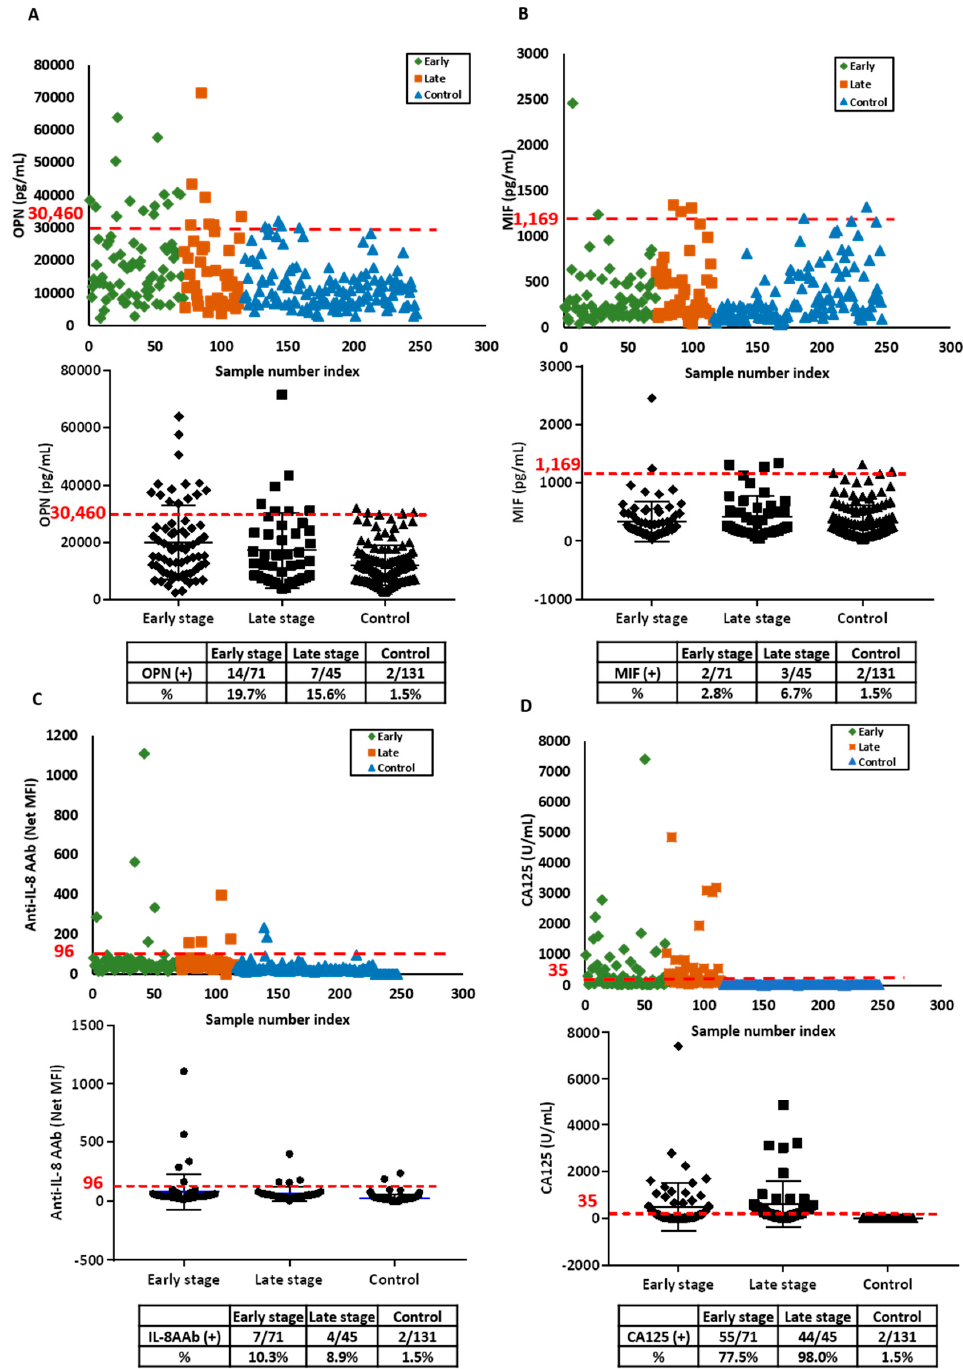
Figure 2. Serum levels of OPN, MIF anti-IL-8 autoantibody and CA125 are elevated in the validation set from ovarian cancer patients and healthy controls. ( A ) OPN antigen; ( B ) MIF antigen; ( C ) anti-IL-8 autoantibody and ( D ) CA125 antigen. In the upper panels, each symbol represents the average of duplicate serum samples from individual early stage ovarian cancer cases (green), late stage ovarian cancer cases (red) or controls (blue). The middle panels contain a scatter plot where the blue line represents the median value in early and late stage case and control groups, respectively. The red dashed lines in each plot represent the cut-o ff value at 98% specificity for OPN, MIF and anti-IL-8 AAb, and cut-o ff value of 35 U / mL for CA125. The lower panel is a table displaying the sensitivity for early and late stage ovarian cancer cases and controls near 98%